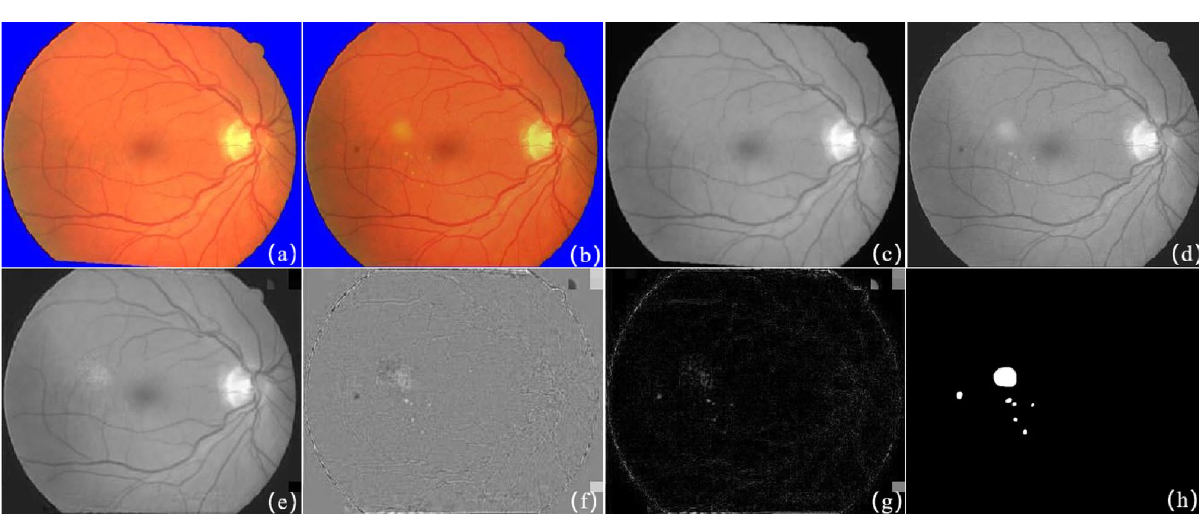
Figure 4. The result of image pair with small lesions. ( a ) Reference image; ( b ) current image; ( c ) grayscale image of ( a ); ( d ) grayscale image of ( b ); ( e ) the reconstructed background of ( d ) based on the proposed method; ( f ) the difference image of ( d ) and ( e ); ( g ) the absolute difference image of ( d ) and ( e ); ( h ) the